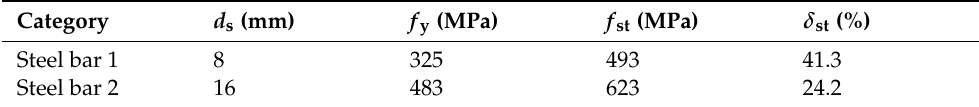
Table 2. Mechanical properties of steel bar.